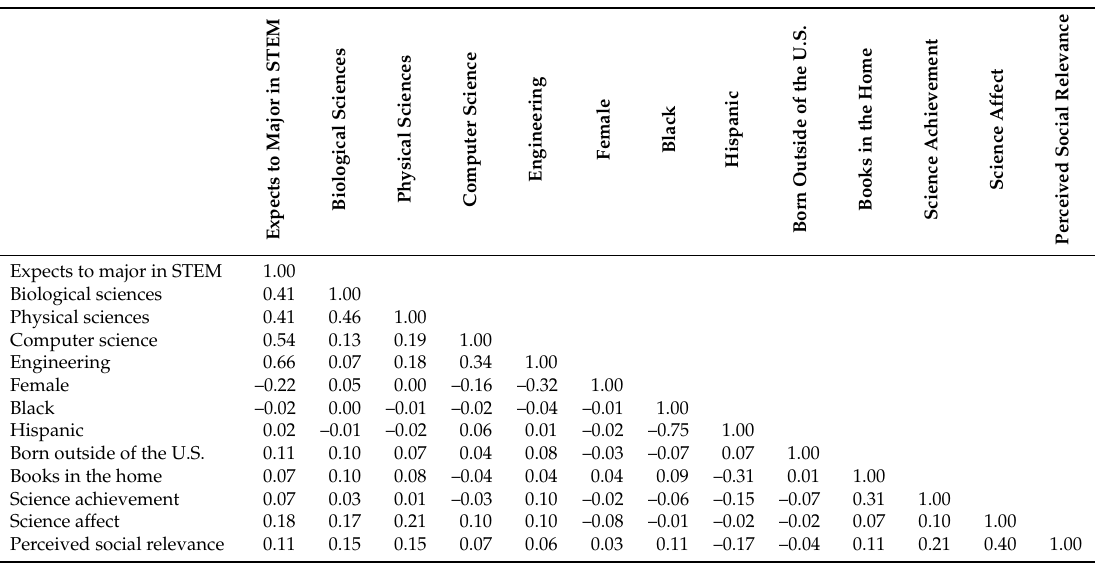
Table A1. Zero-order correlations between